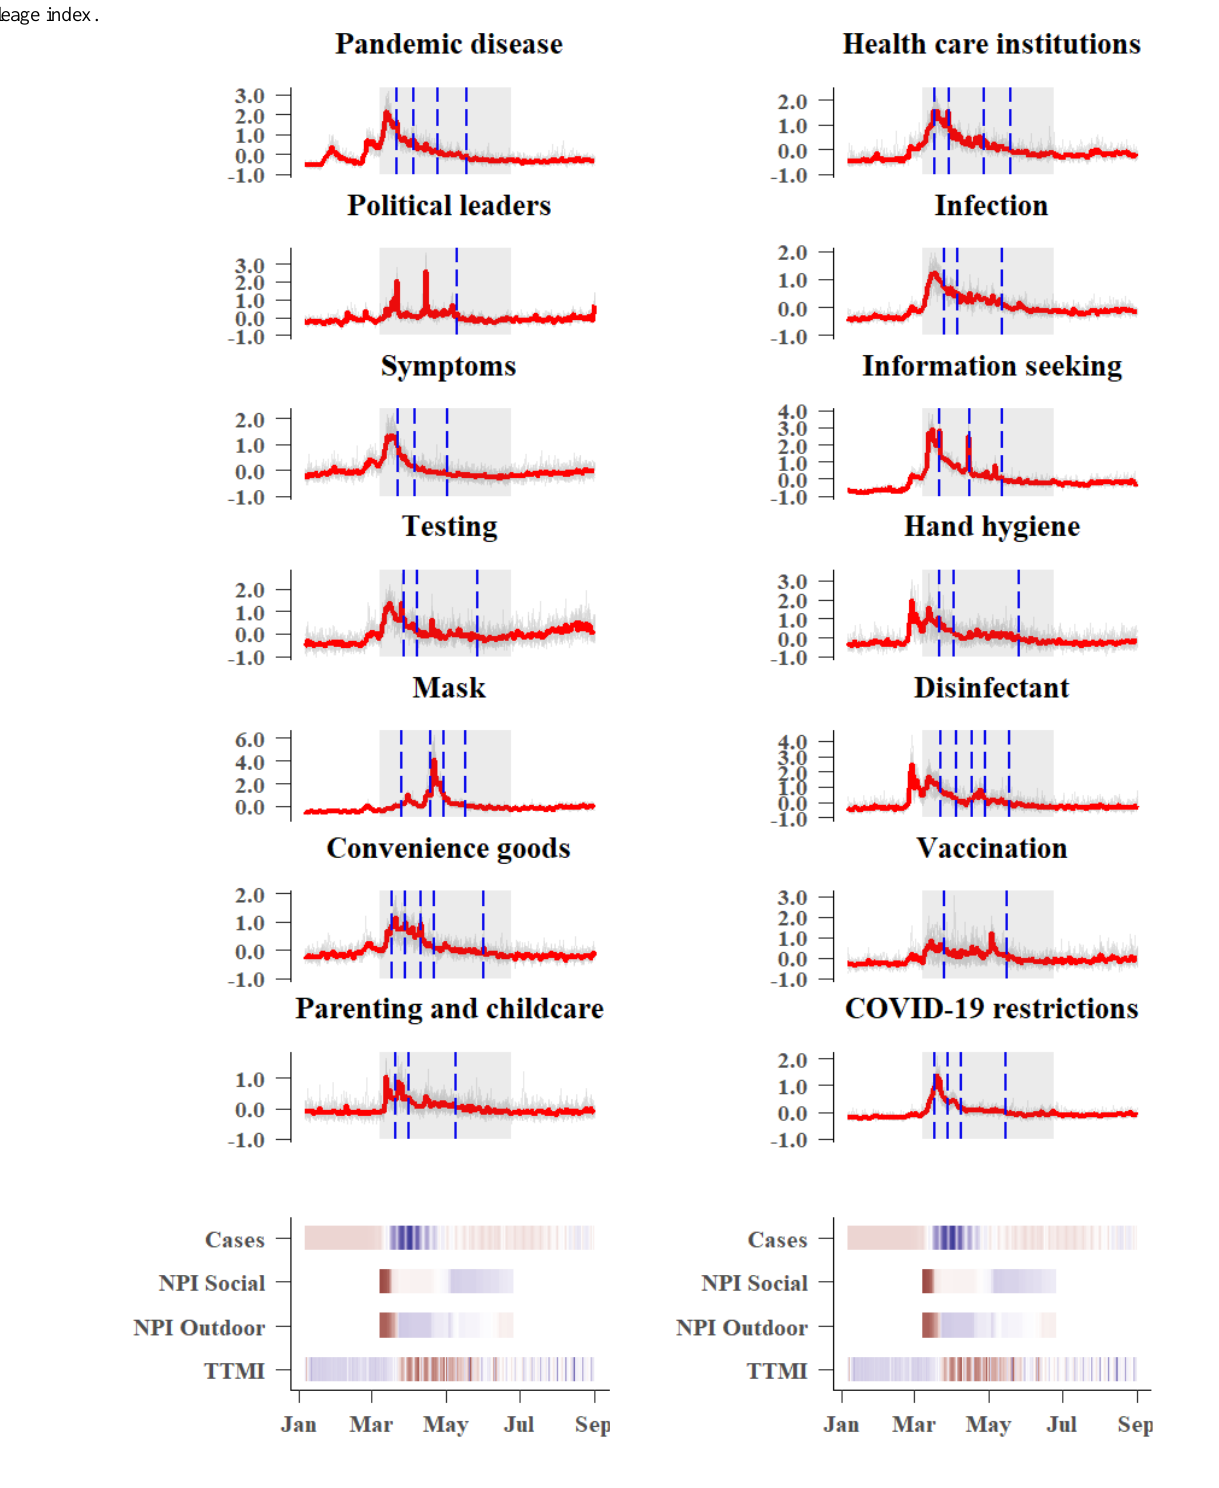
Figure 2. Z-standardized Google Trends for the first 14 domains. The red function indicates the trend for Germany, while the grey functions correspond with the trends for the 16 federal states. The grey shaded area represents the lockdown period in Germany from March 8 to June 26, 2020. Change points, indicating level changes, are represented by the vertical blue dashed lines. The intensity of daily new infections (Cases), countermeasures (NPI Social and NPI Outdoor), and the proxy for the state of economy (TTMI) is plotted below. NPI: nonpharmaceutical intervention; TTMI: truck toll mileage